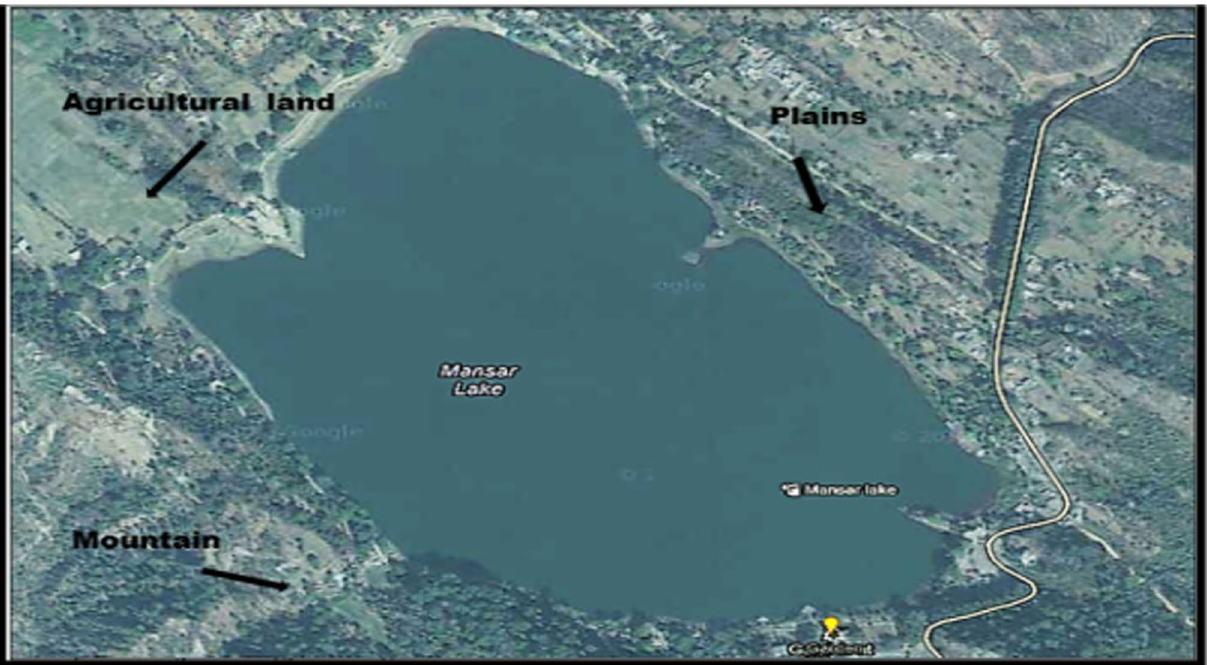
Fig. 1 Satellite image of Lake Mansar ( Source Internet